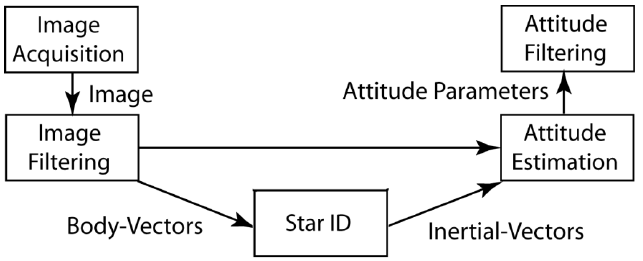
Figure 1. Typical Star-Tracker Image-based Attitude Determination Flow.